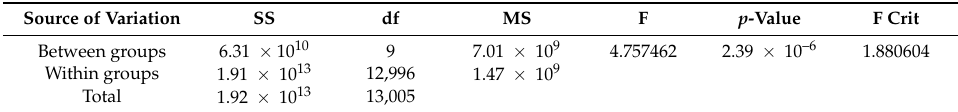
Table 3. ANOVA mean differences across